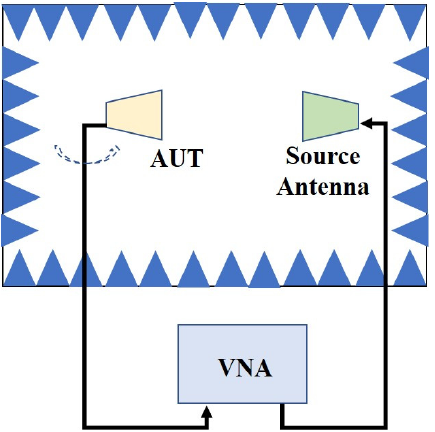
Figure 12. Schematic diagram of radiation pattern measurement setup.